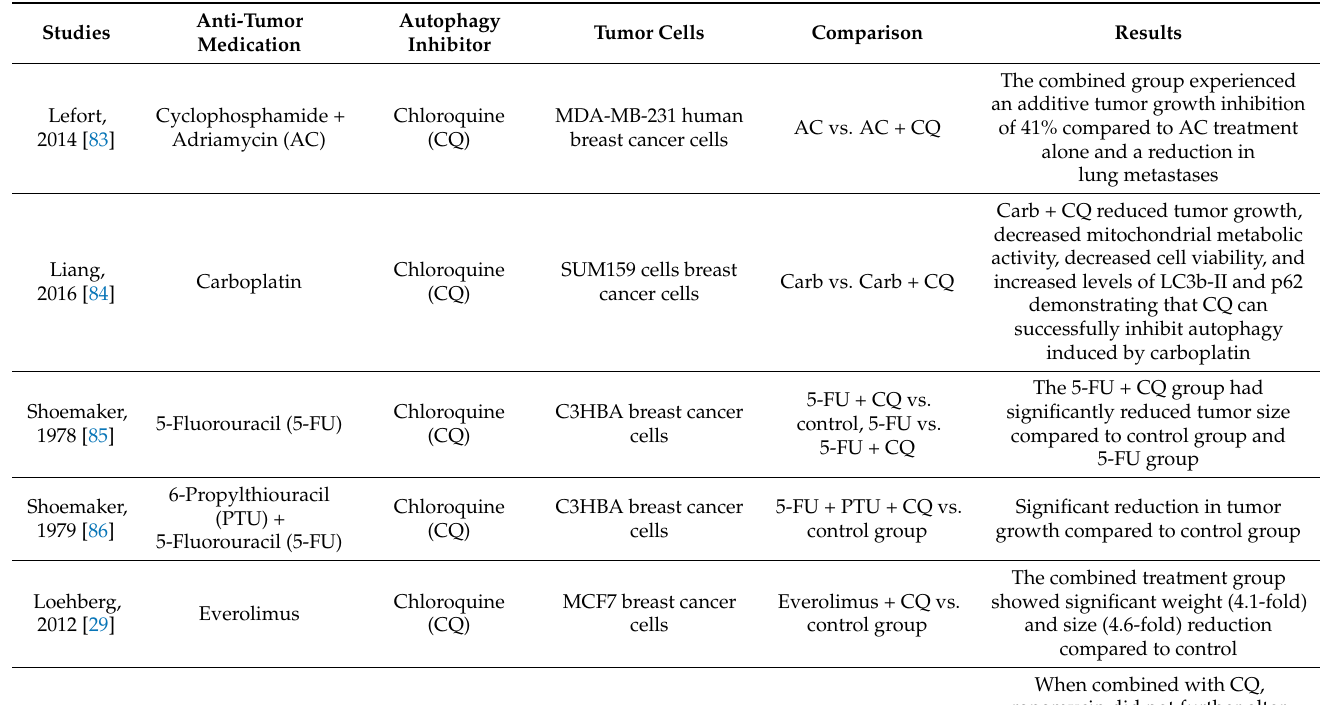
Table 2. Preclinical in vivo studies evaluating the combined use of anti-tumor drugs with HCQ or CQ in breast